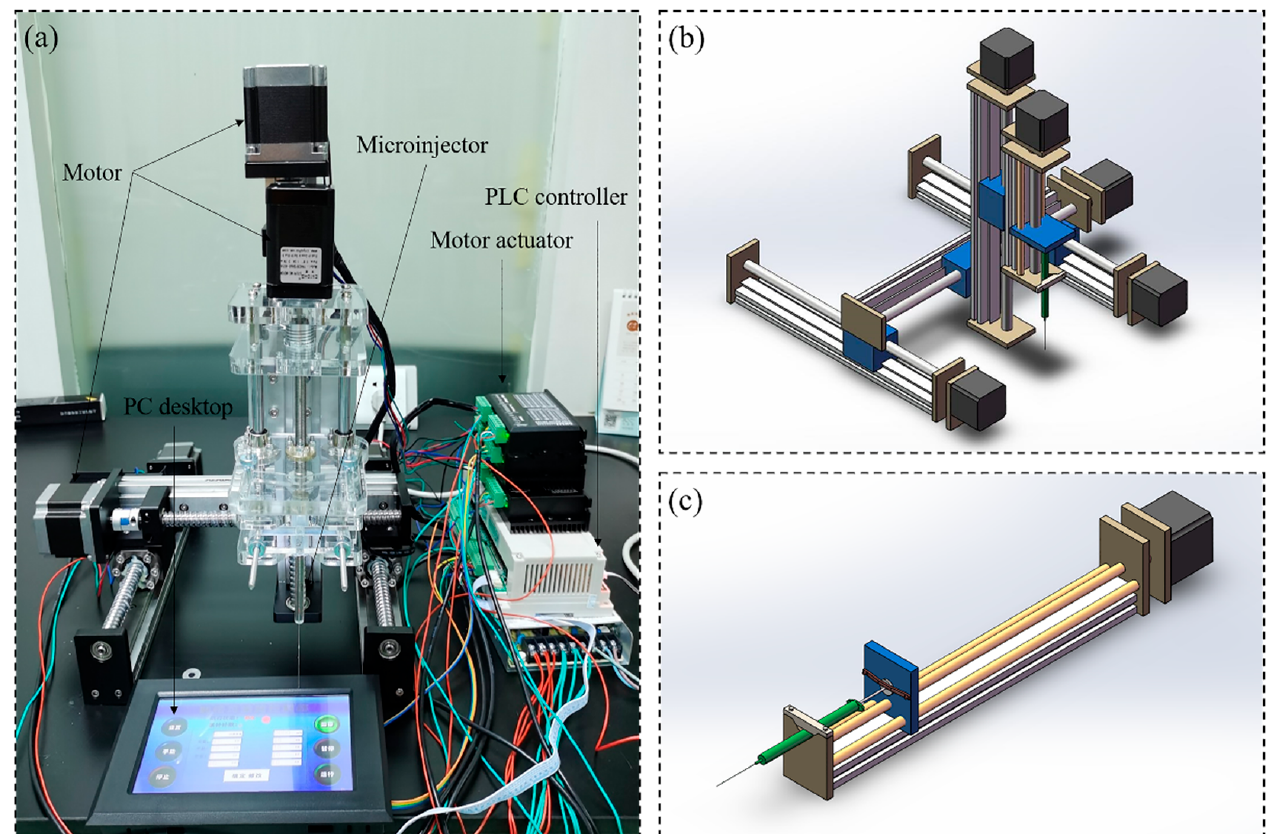
Figure 1. The three-dimensional precision automatic pipette: ( a ) picture of real products, ( b ) schematic diagram for total equipment, ( c ) schematic diagram for mini-pump.